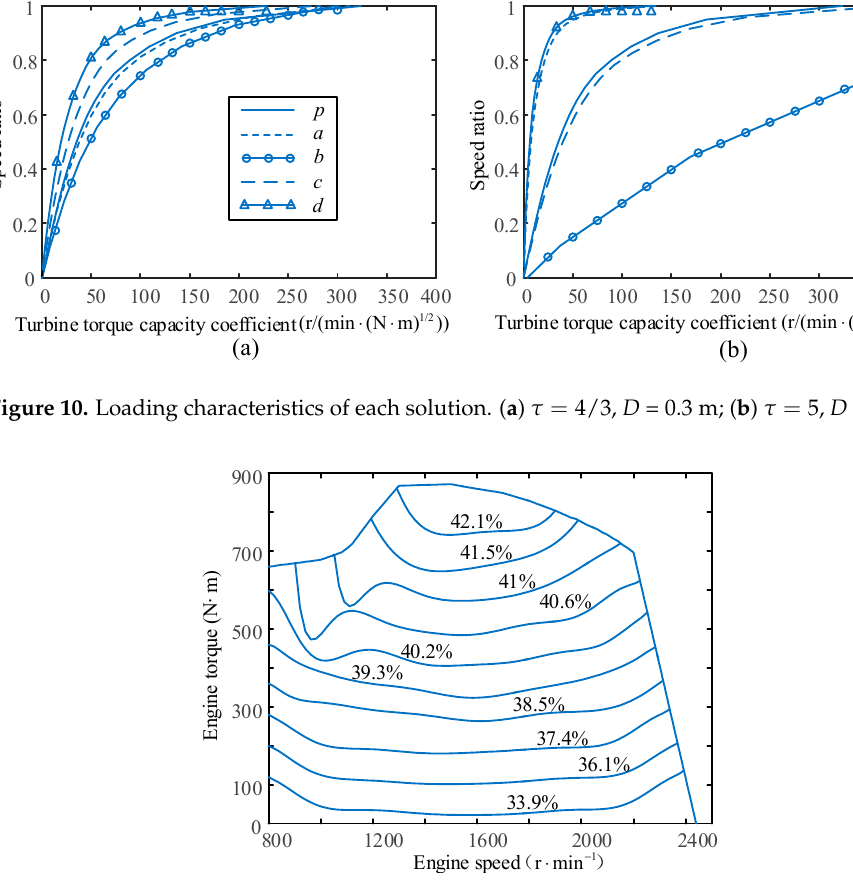
Figure 11. Engine efficiency.